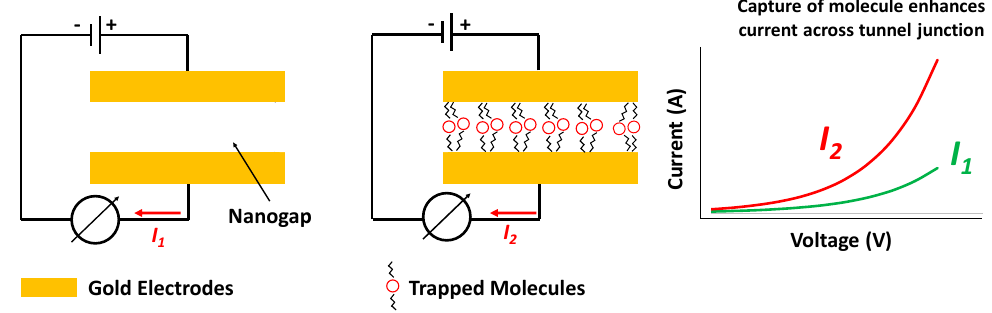
Figure 1. Schematic of tunneling nanogap junctions. Trapping the molecules within the nanogap alters the junction I–V characteristics.